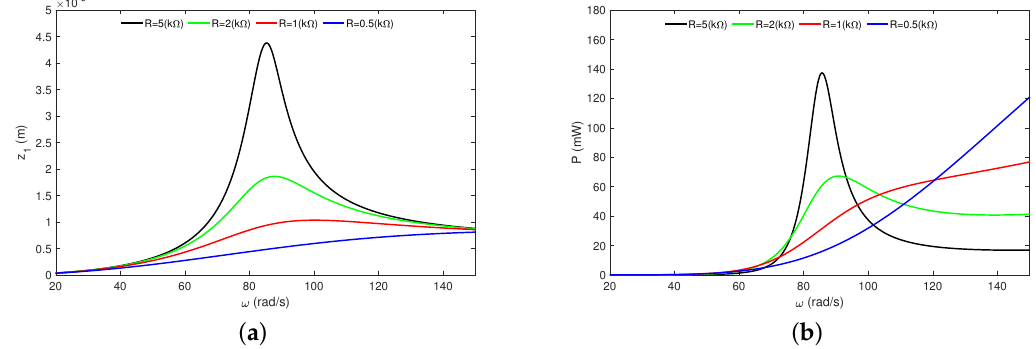
Figure 8. Analytical HBM results. Magnet’s resonance curves ( a ) and recovered power ( b ) under the resistance influence. The results have been calculated for amplitude Q = 0.6 mm and have obtained from Equations (27) and (28). All resonance curves are